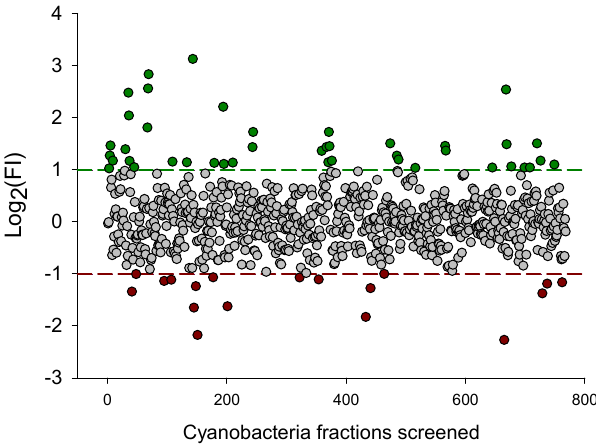
Figure 3. Log 2 transformed fold induction (FI) values of the 768 cyanobacteria fractions screened with the mpFN26A[Fluc]/mpGL4.35[Nluc] sensor system, in triplex mode, that passed the quality control analysis. Red dots (n = 18) correspond to fractions featuring inhibition (Log2 FI ≤ − 1), green dots to fractions showing induction (Log2 FI ≥ 1) (n = 42), and grey dots correspond to fractions showing no induction nor inhibition (-1<Log2 FI ≤ 1) of PPARs activity (n = 708). Dimethyl sulfoxide (DMSO) concentration did not exceed 0.5 % per well.